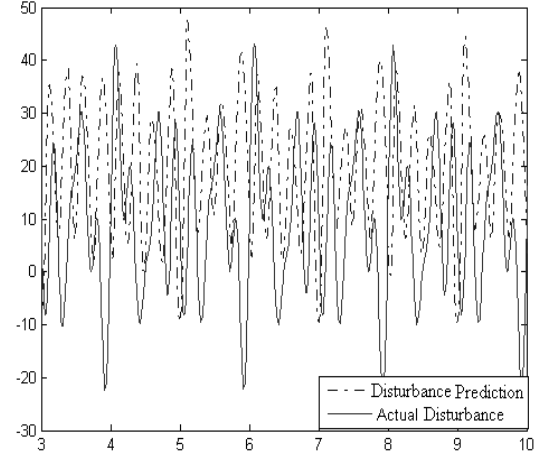
Fig. 3.Comparisons between disturbance prediction and actual disturbance